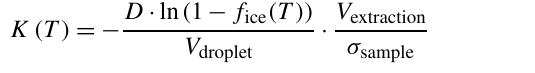
Figure 4. Cumulative nucleus concentration at − 34 ◦ C (K( − 34 ◦ C)) of the analysed core samples of Tree A (grey), Tree C (blue) and Tree I (green). Bark samples are marked with a hollow symbol, and bast samples are marked with a half-filled symbol. Filled symbols correspond to inner wood samples. To assign the depth of the different core segments, the centre of the segments was used. The sizes of the segments are visualized with corresponding horizontal lines. INM concentration increases towards outer layers of the trunk. The bast sample from Tree A does not freeze